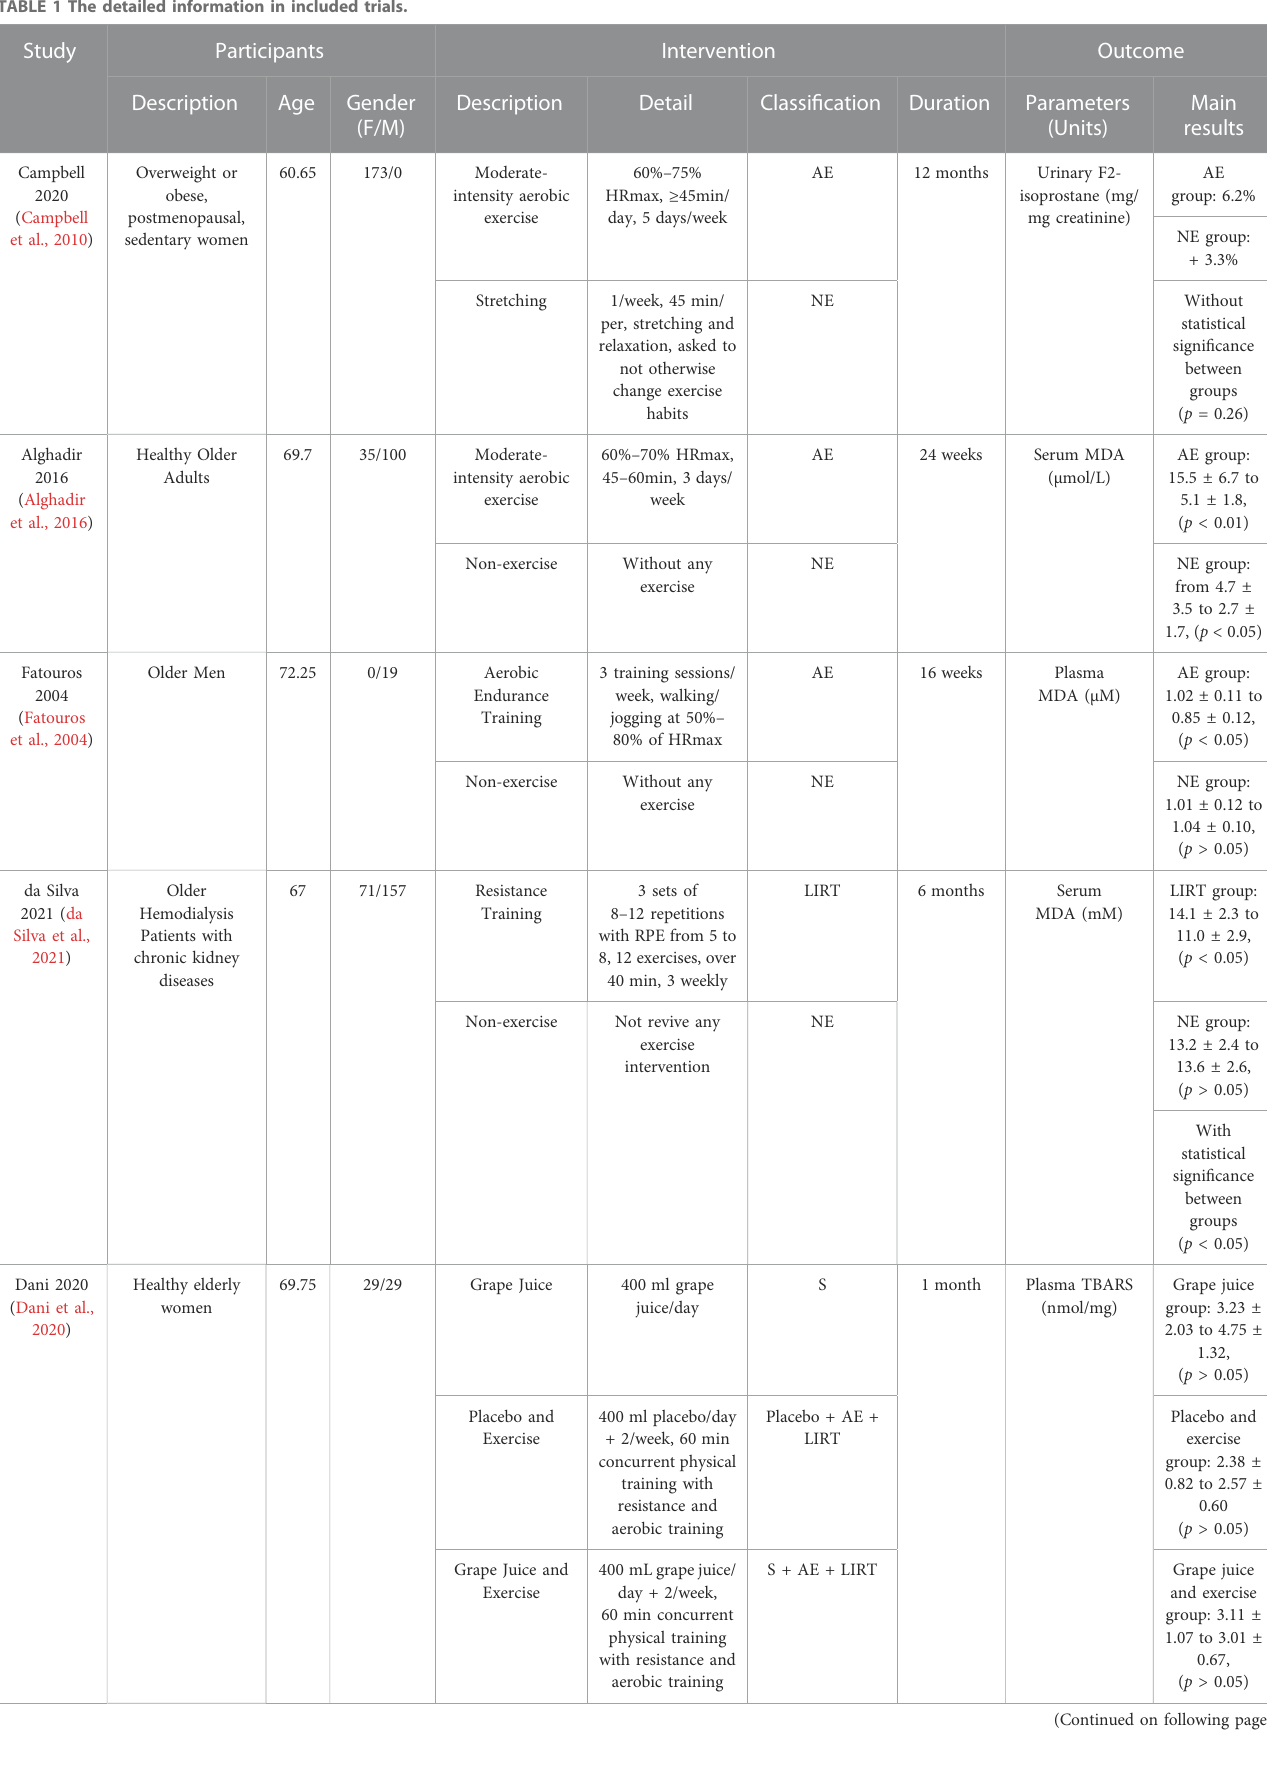
TABLE 1 The detailed information in included